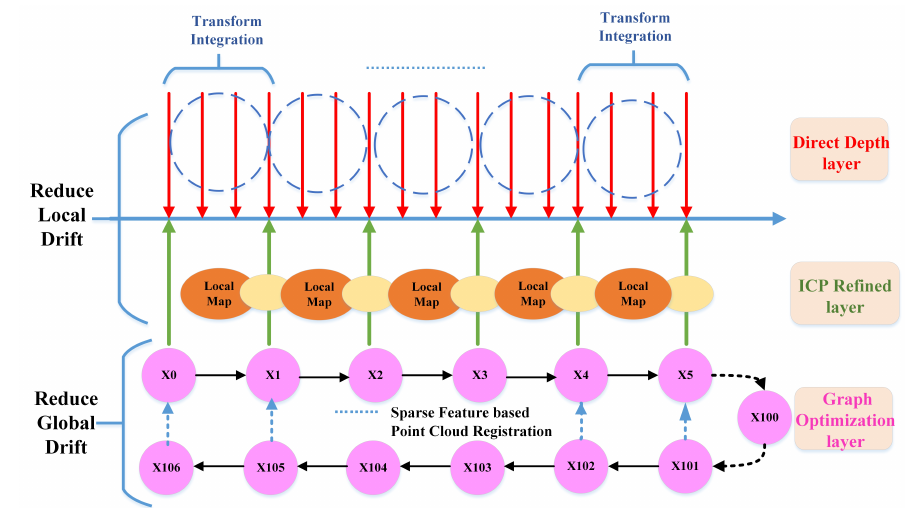
Figure 1. Overview of the Direct Depth SLAM (simultaneous localization and mapping) System, composed of three staggered layers, namely Direct Depth layer, ICP (iterative closet point) refined layer and Graph Optimization layer. The red arrows represent the frame to frame pose estimation of the Direct Depth layer. The transform integration module accumulates consecutive frames to construct a local map (orange ellipse in image). The green arrows represent the keyframes and their associated point clouds are denoted as yellow ellipses. The keyframes will be aligned to the constructed local map to reduce the local drift of direct depth odometry. The refined pose is stored as vertex X i (pink circle) in the pose graph of the Graph